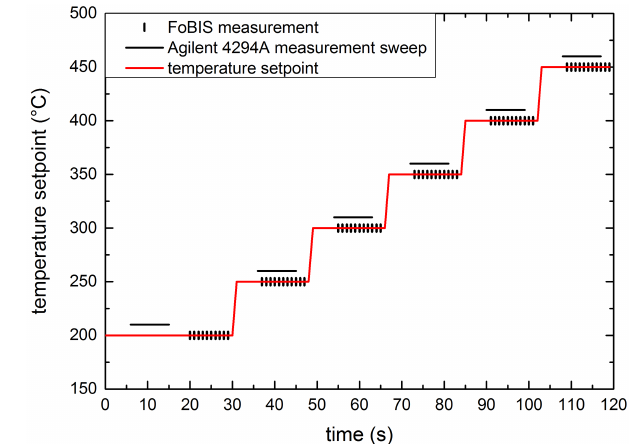
Figure 4. Temperature set points and timing of impedance mea- surements during temperature cycle.